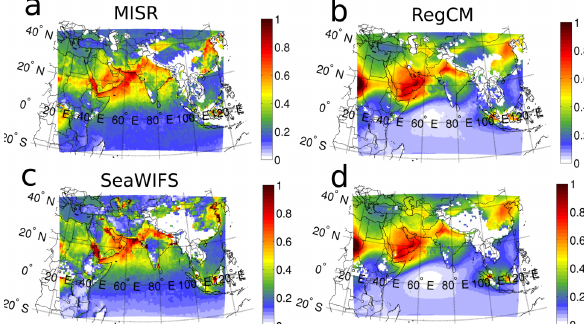
Figure 7. JJAS 2000–2009 AODs seen from the (a) MISR sen- sor and (b) as simulated by RegCM “ dust ” simulation for the full CORDEX-India domain. JJAS composite averages are built form monthly observations and model outputs. Regions of missing ob- servations are screened out from the model averages. (c, d) Same as (a, b) but using the SeaWIFS AOD observations. All modeling results represent a 3 member’s ensemble mean.